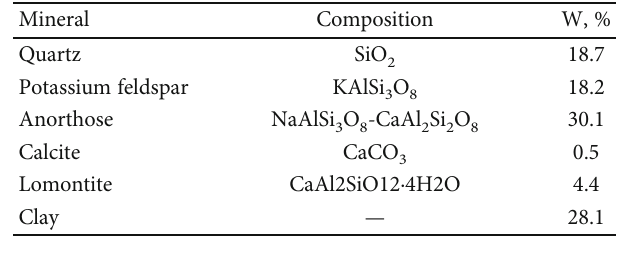
Table 3: Mineral composition of the cores.